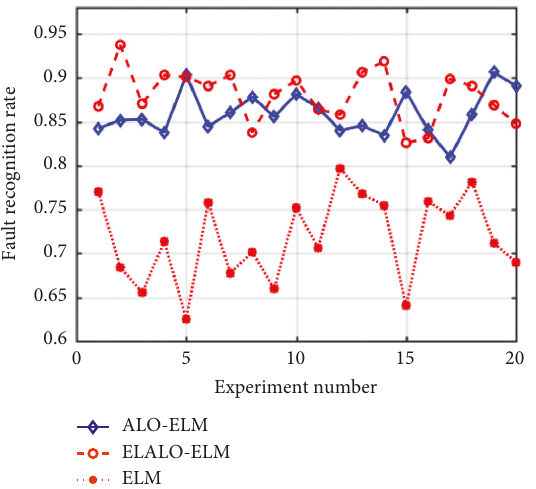
Figure 11: The recognition rate results of the three types of net- works 20 times.